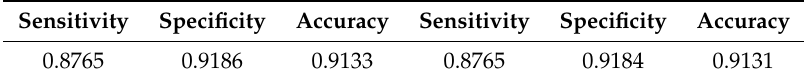
Table 1. Sensitivity, specificity, and accuracy of our classification model applied to the raw data set (left) and calibrated data set (right).